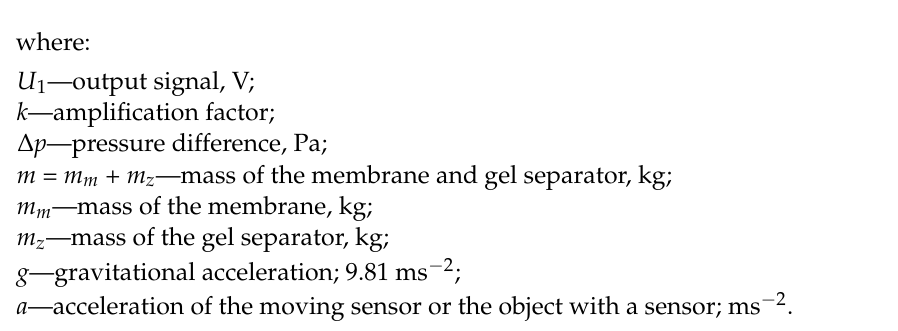
Figure 12. Deformation of membranes for the occurrence of pressure difference p 1 > p 2 and for the